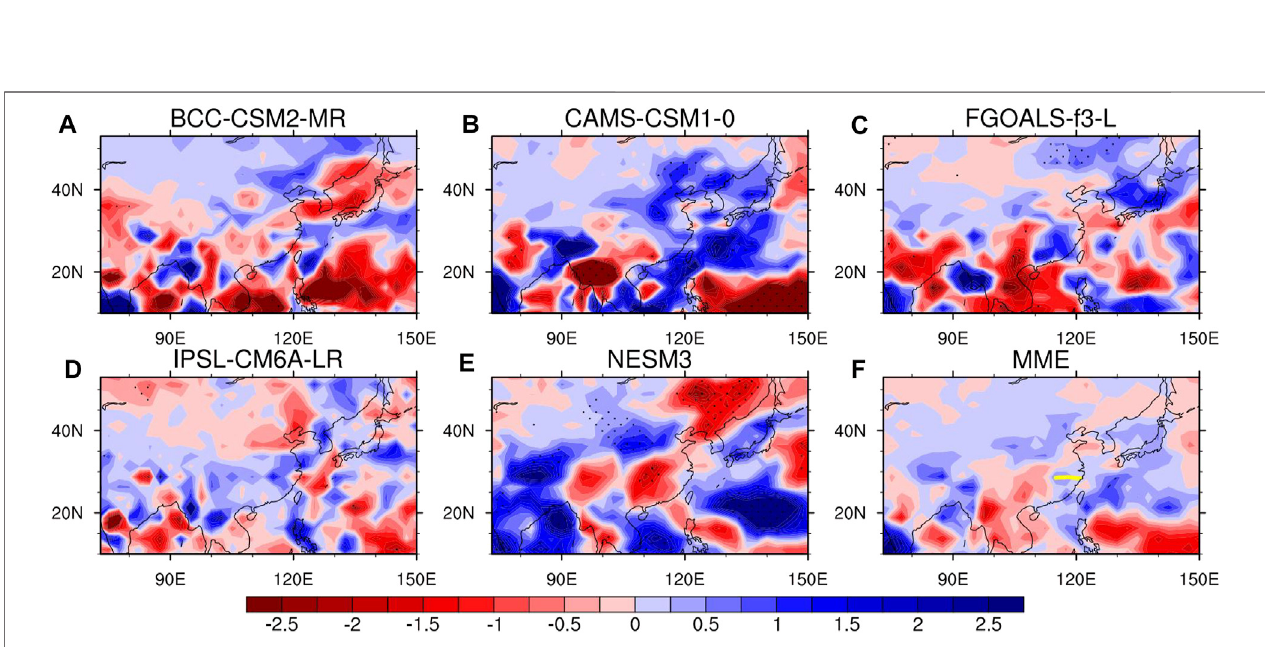
FIGURE6| Thechangesoftheprecipitationanomaly(mm/day)duringstrong EPeventsinthefollowingsummerbetweentheSSP5-85 andhistorical experiments for CMIP6 (SSP5-85-historical, the yellow curve is constituted with the maximum precipitation anomaly during strong EP events in historical experiment).